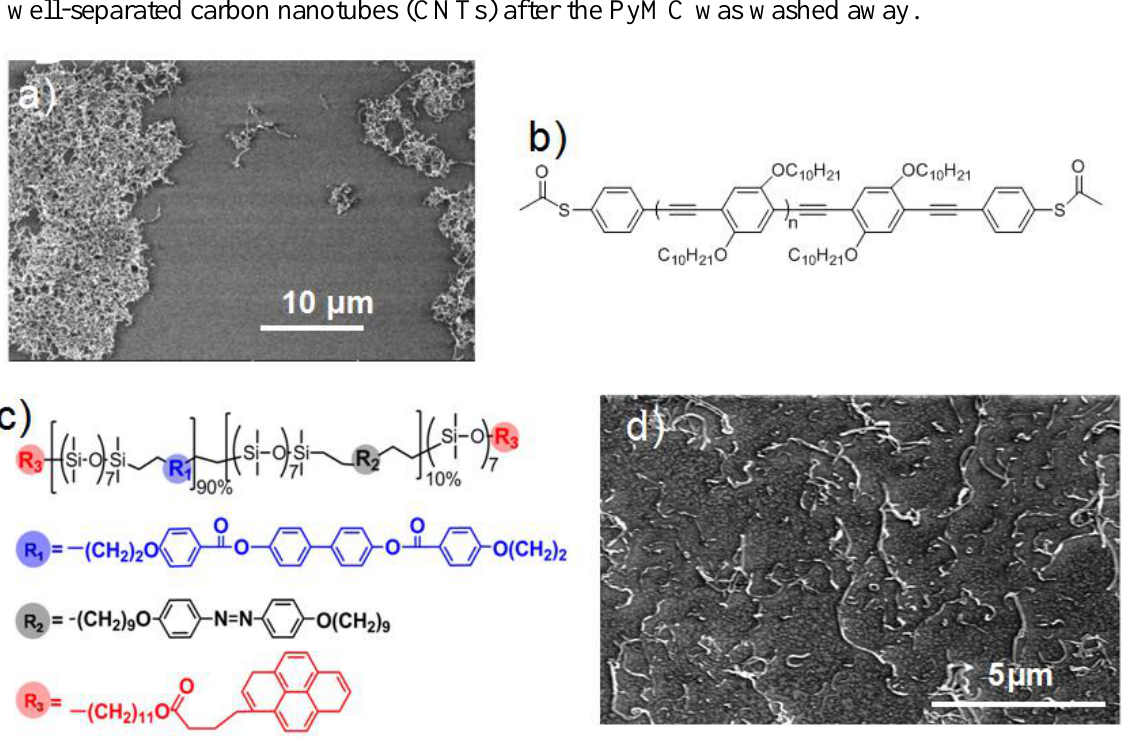
Figure 2. ( a ) Clustered multi-walled carbon nanotubes (MWNTs) after sonication in pure petroleum ether; ( b ) poly(p-phenyleneethynylene) used for single-walled carbon nanotube (SWNT) dispersion; ( c ) chemical structure of PyMC; ( d ) the morphology of the well-separated carbon nanotubes (CNTs) after the PyMC was washed